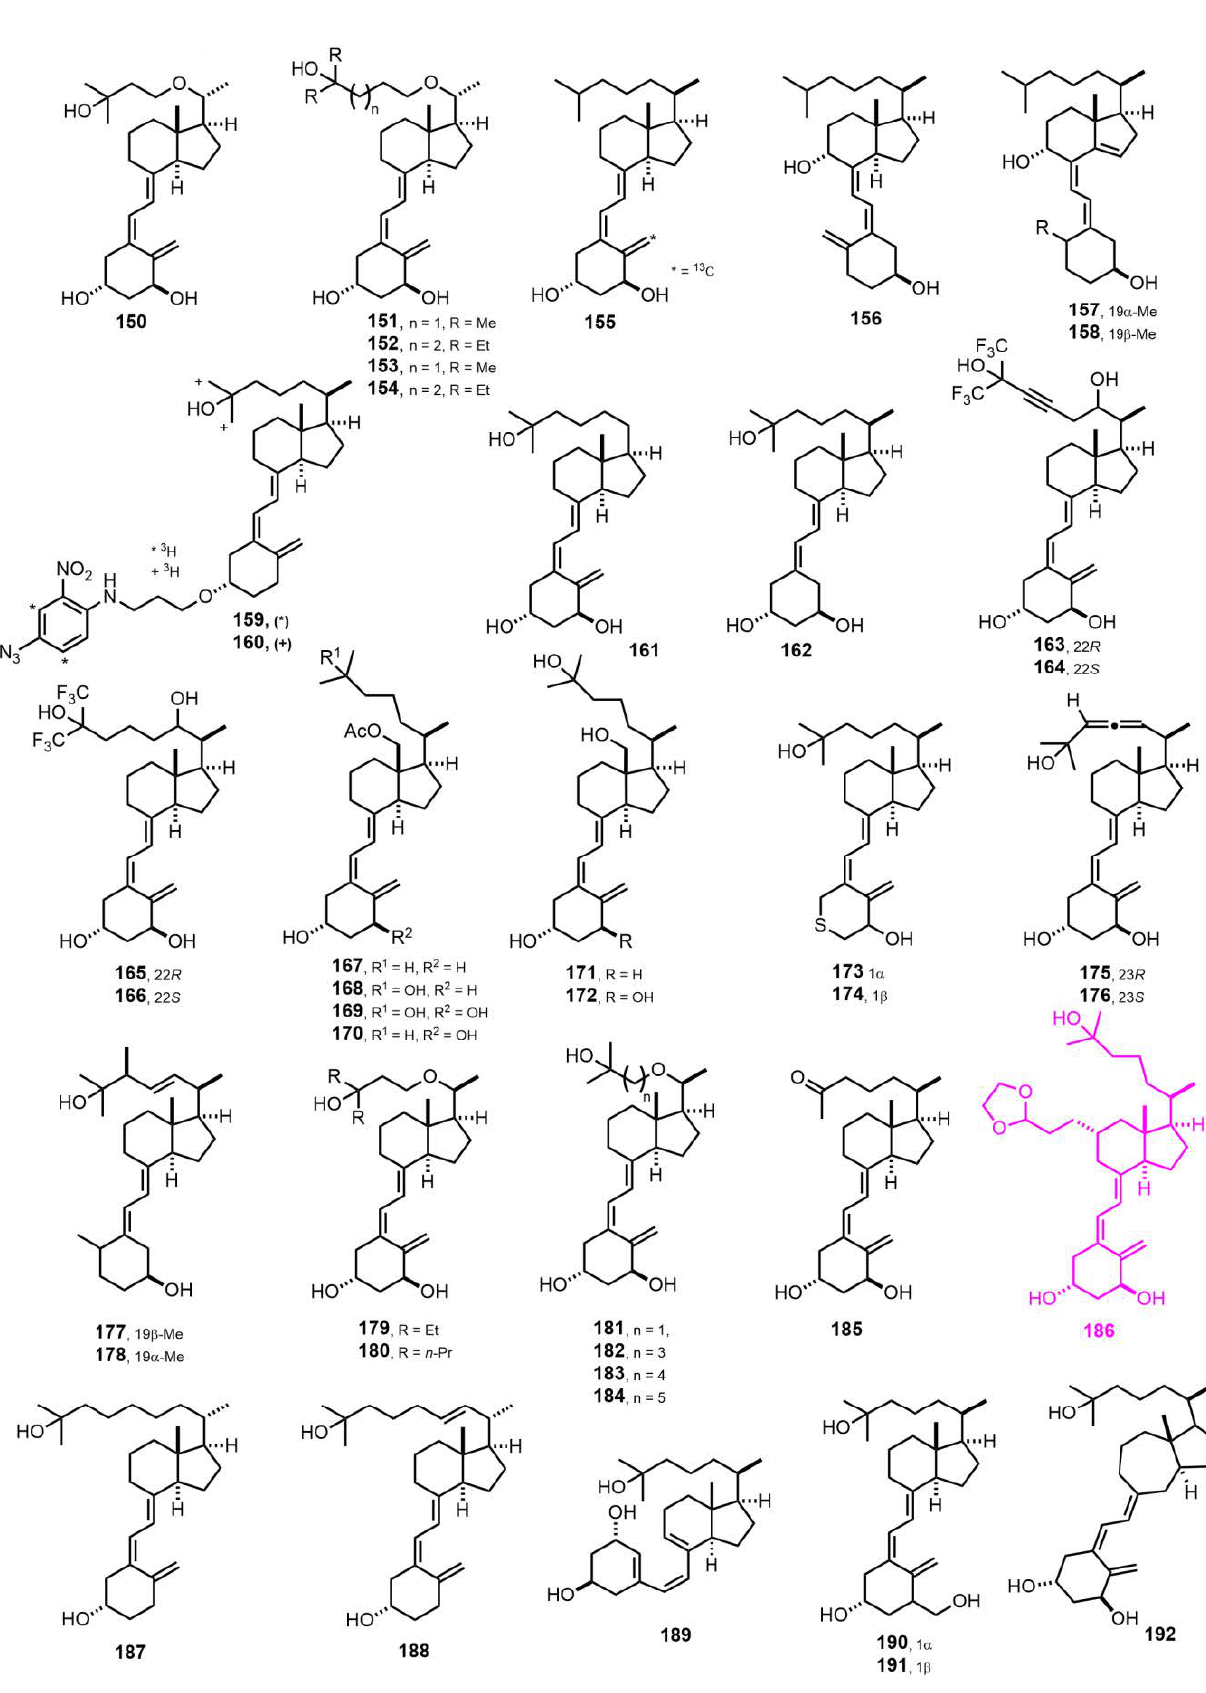
Figure 5. (1991-1992) [95 – 117].